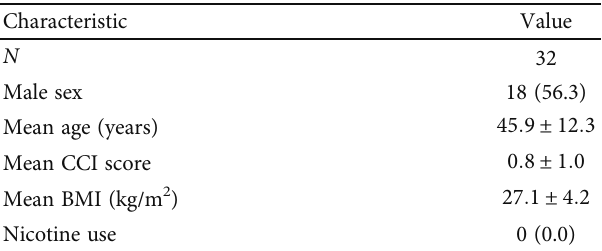
Table 3: Procedural details.